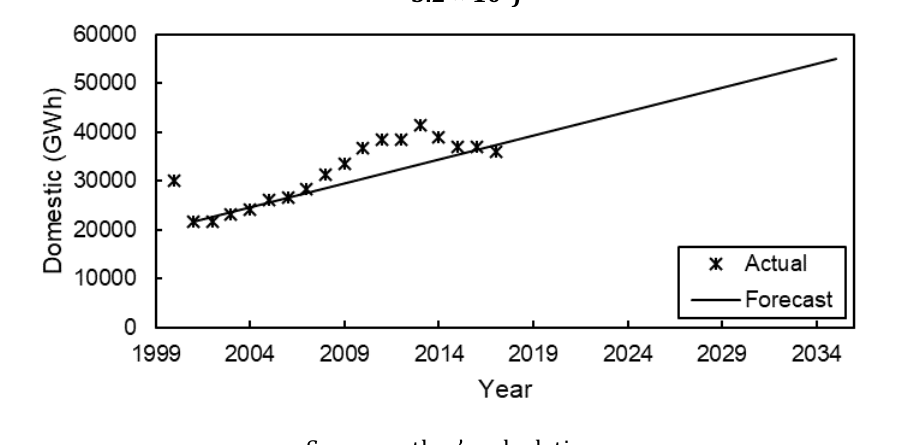
Figure 5: Electricity demand forecasting electricity for domestic consumers (standard error = 3.2 × 10 3 )